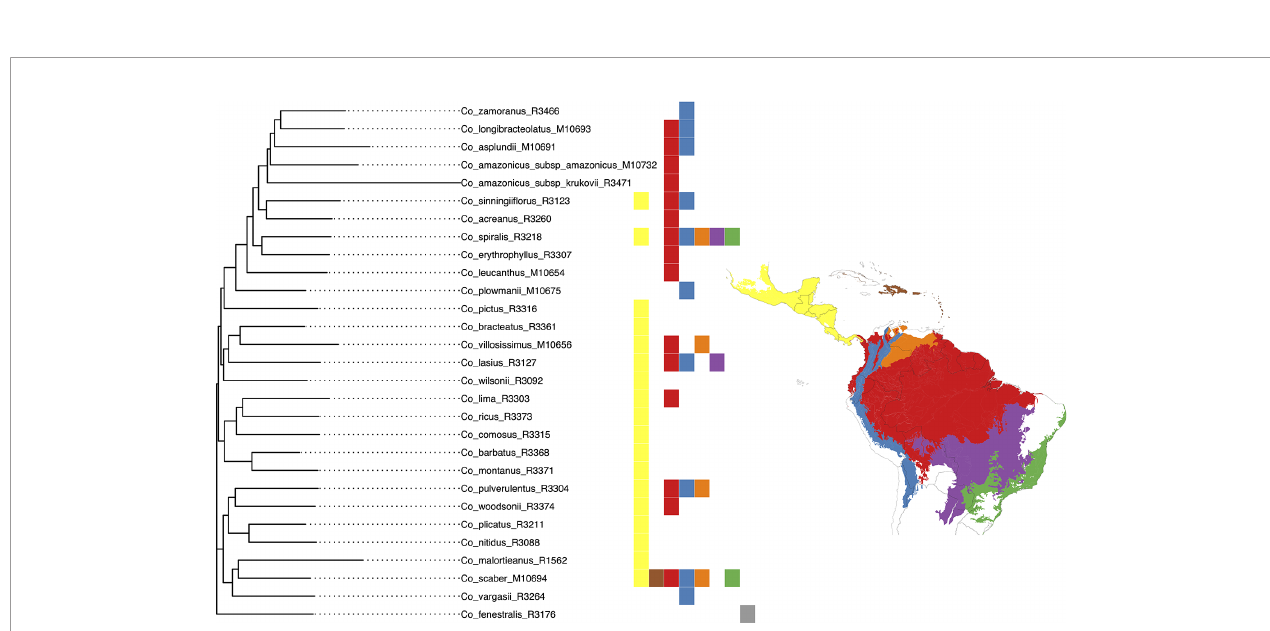
FIGURE 8 | Classi fi cation of the geographical distribution of the species of Costus included in the analyses. The regions from north to south are 1. Mesoamerica, 2. West Indies, 3. Amazon, Interandean Valleys and Choco-Darien region, 4. Northern and Central Andes, 5. Llanos region, 6. Cerrado, and 7. Atlantic